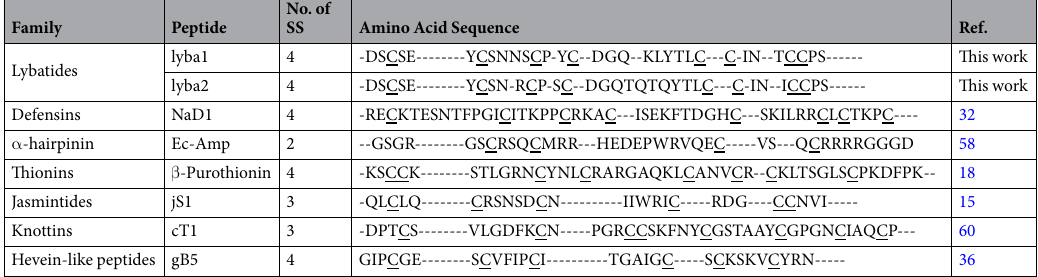
Table 1. Sequence alignment of plant CRPs from different CRP